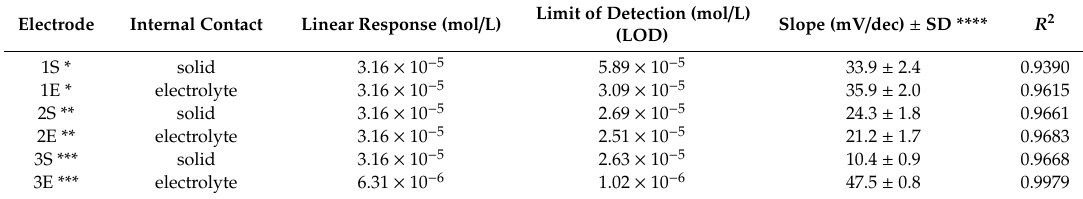
Table 1. The response characteristics of electrodes without Fe x O y nanoparticles (NPs).